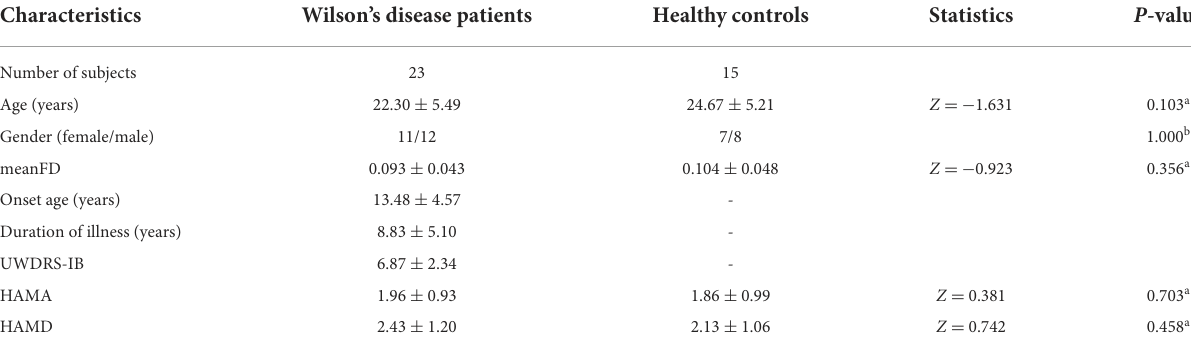
TABLE 1 Demographic and clinical